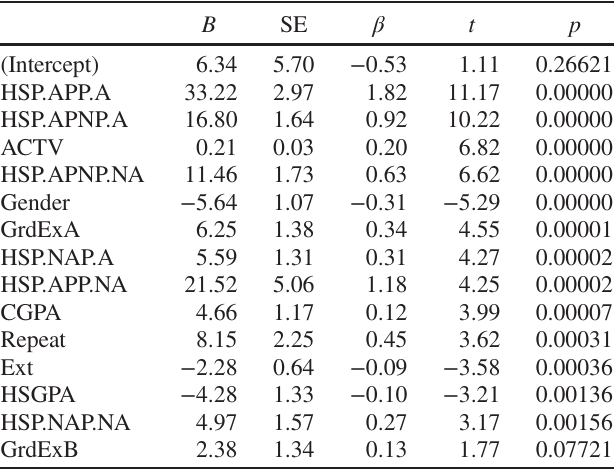
TABLE V. Optimal pretest model with Bonferroni correction. B is the regression coefficient, SE the standard error, β the standardized regression coefficient, t the t statistic, and p the probability a value as large or larger than t occurred by